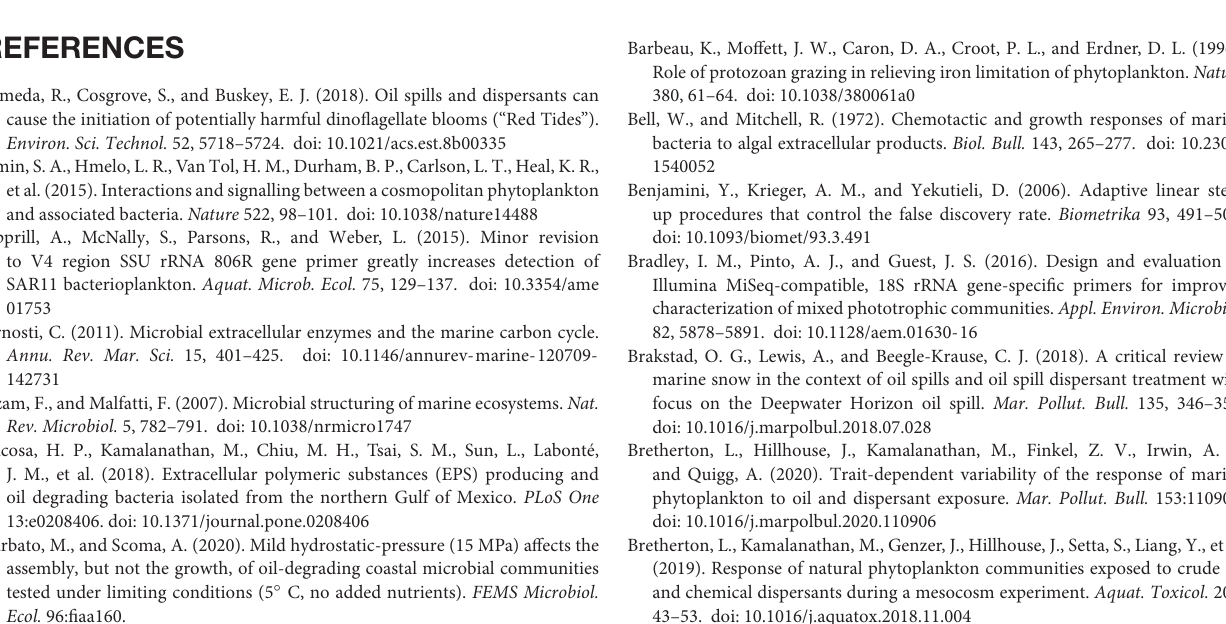
Supplementary Figure 1 | Radiotracer signals from the short-term experiment. (a) eukaryotic phototrophic organic matter (CPM), (b) prokaryotic organic matter (CPM), (c) phototrophic EPS (CPM), (d) heterotrophic EPS (CPM), (e) prokaryotic uptake of phototrophic organic matter (CPM), and (f) eukaryotic uptake of heterotrophic organic matter (CPM). Supplementary Figure 2 | Phytoplankton-bacteria interaction. (a) Linear correlation of phototrophic EPS (CPM) vs. eukaryotic uptake of heterotrophic organic matter (CPM) in both short and long-term experiment, and (b) Distribution of ratio of phototrophic EPS (CPM) and eukaryotic uptake of heterotrophic organic matter (CPM) in both short and long-term experiment. Supplementary Figure 3 | Photosynthetic physiology of different classes of phytoplankton in the short-term experiment. (a) Alpha/light harvesting ability ( µ mol e − 1 . µ mol photons − 1 ) in the short-term experiment, (b) relative electron transport rates ( µ mol e − . m − 2 . s − 1 ) in the short-term experiment. Supplementary Figure 4 | Photosynthetic performance and characteristics of phytoplankton. (a) F v / F m , maximum quantum yield (relative units) of phytoplankton in the short-term experiment, (b) Photosystem II connectivity ( ρ , relative units) in the short-term experiment, (c) Sigma, absorption cross-section area of photosystem II ( σ , Å (Quanta) − 1 ) in the short-term experiment, (d) F v / F m , maximum quantum yield (relative units) of phytoplankton in the long-term experiment, (e) Photosystem II connectivity ( ρ ) in the long-term experiment, and (f) Sigma, absorption cross-section area of photosystem II ( σ , Å (Quanta) − 1 ) in the long-term experiment. Supplementary Figure 5 | Exopolymeric substance (EPS) composition in the long-term experiment. (a) Carbohydrate concentration of EPS ( µ g.L − 1 ), (b) Protein concentration of EPS ( µ g.L − 1 ), (c) Uronic acids concentration of EPS ( µ g.L − 1 ), and (d) Total EPS concentration of EPS ( µ g.L − 1 ). Supplementary Figure 6 | Relative ASV abundance of microbes. (a) Relative prokaryotic abundance in the control treatment, (b) Relative prokaryotic abundance in the oil treatment, (c) Relative eukaryotic abundance in the control treatment and (d) Relative eukaryotic abundance in the oil treatment through time in the long-term experiment. Supplementary Figure 7 | ASV Abundance of members belong to class Gammaproteobacteria in (a) the control and (b) the oil treatment through time in the long-term experiment. Supplementary Table 1 | Number of sequenced and processed reads and accession numbers for the 16S and 18S rRNA